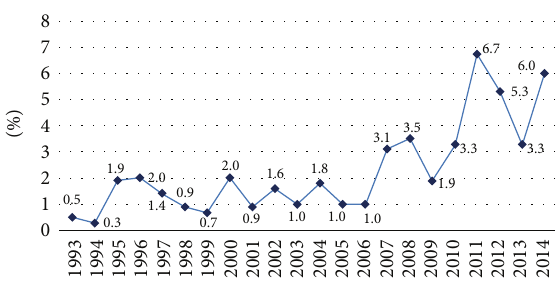
Figure 1: MCI/MI hypersensitivity data in percent (MCI/MI hypersensitive patients/tested patients in the year) at the Allergy Outpatient Unit of the Department of Dermatology, Venereology andDermatooncologyoftheSemmelweisUniversity1993–2014( 𝑛 = 14693